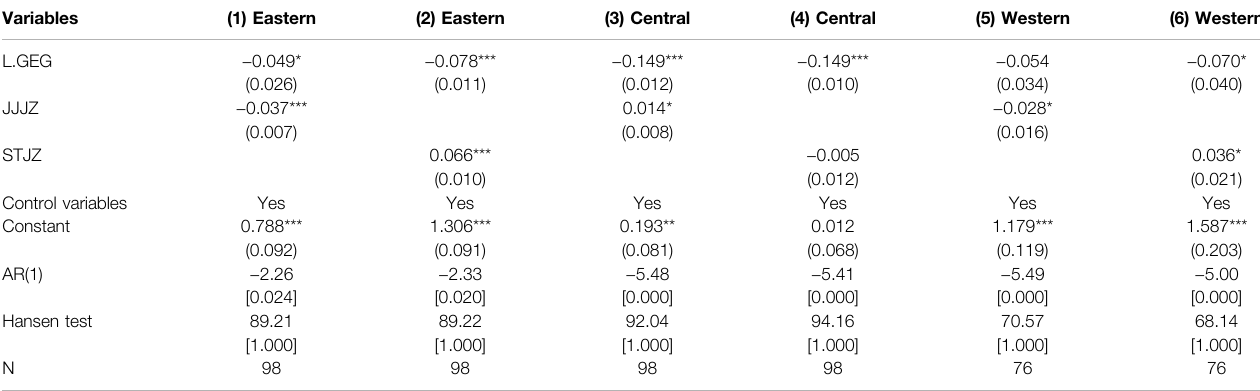
TABLE 8 | Regional heterogeneity results under economic and ecological competition. Variables